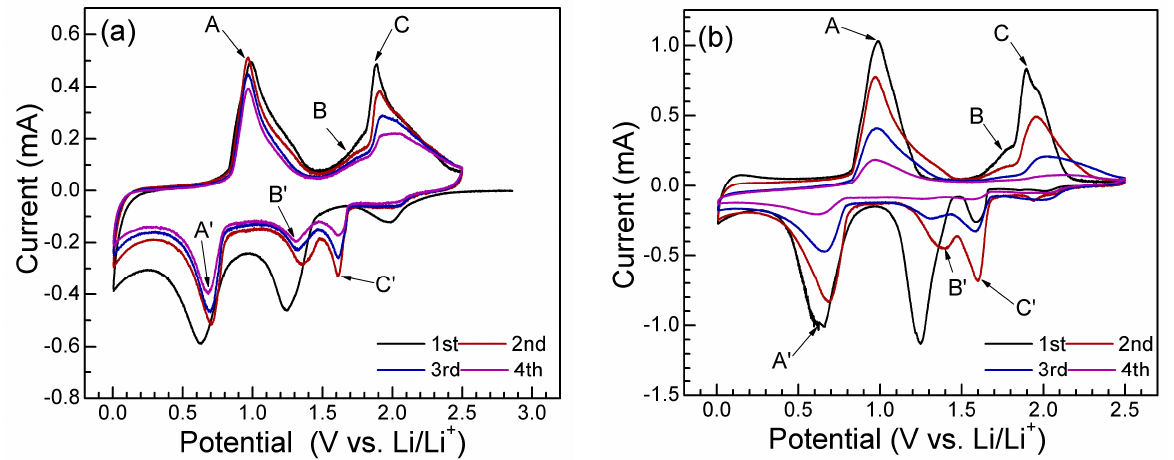
Figure 3a. The small peak at 2.0 V is related possibly to the insertion reaction of Li ion into